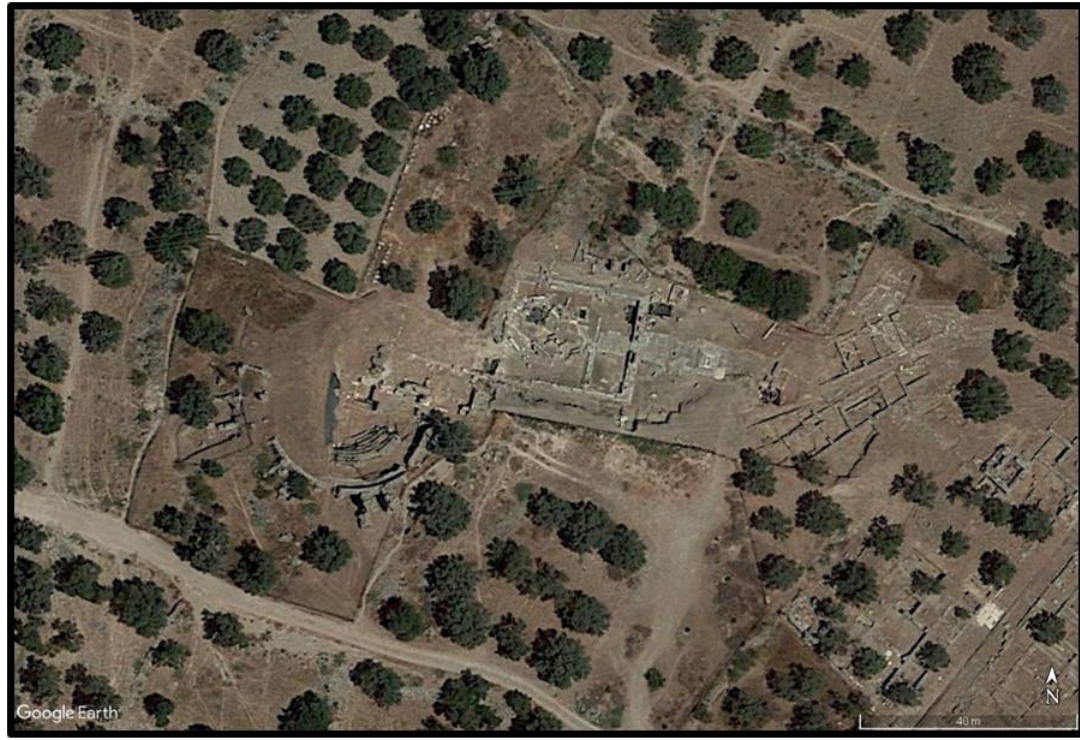
Figure 1. Aerial view of the area of the sanctuary of Apollo Pythios at Gortyna (from Google